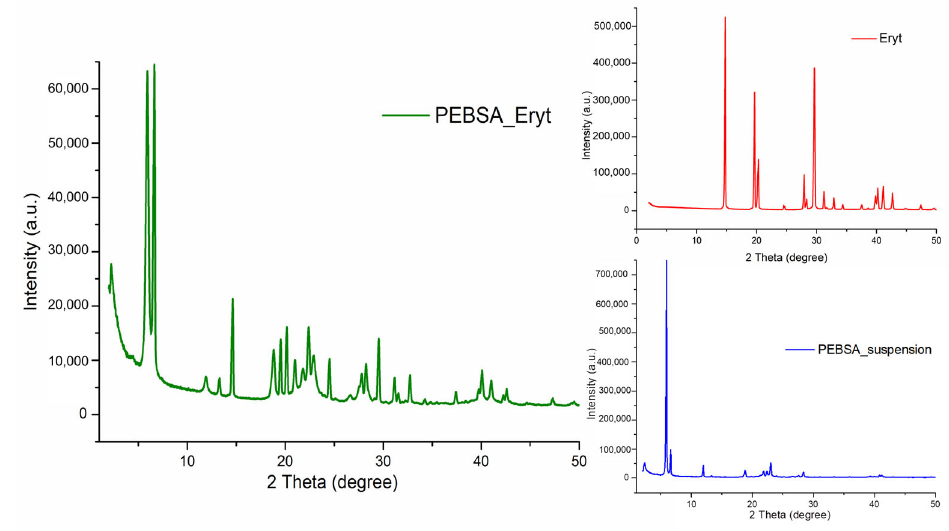
Figure 8. XRD diffractograms of PEBSA_Eryt, Eryt, and PEBSA_suspension.